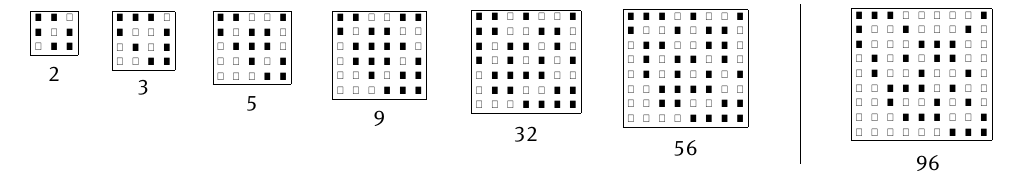
Figure 1: 0/1 -matrices with maximal determinant that represent acute 0/1 -simplices.